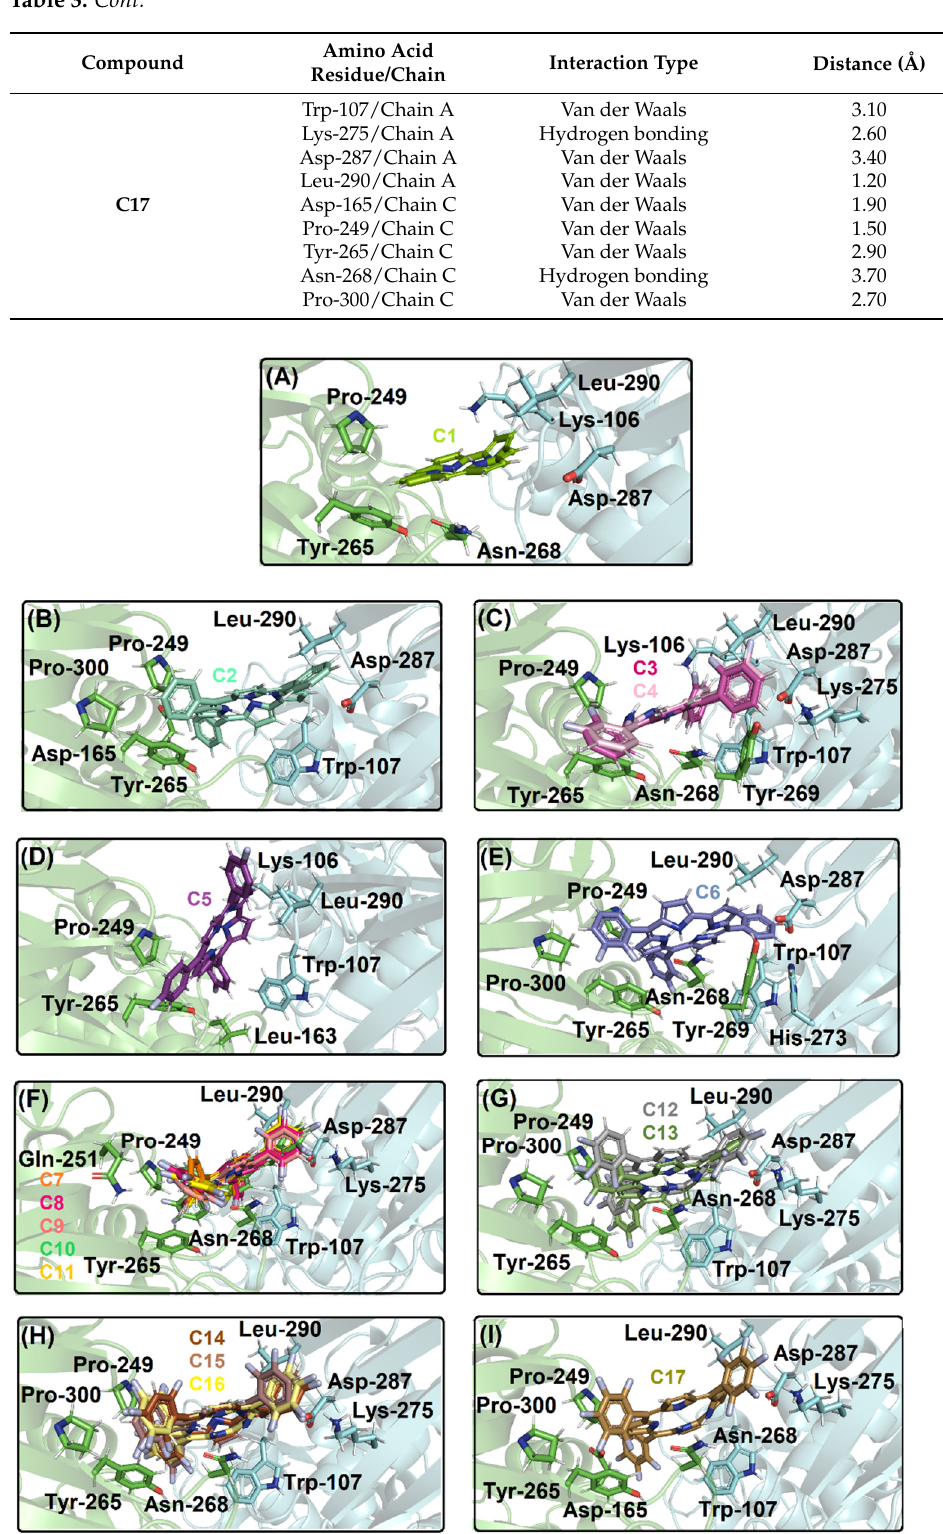
Figure 5. The best docking pose into the catalytic site of PL pro for ( A ) C1 ; ( B ) C2 ; ( C ) C3 , C4 ; ( D ) C5 ; ( E ) C6 ; ( F ) C7 , C8 , C9 , C10 , C11 ; ( G ) C12 , C13 ; ( H ) C14 , C15 , C16 ; and ( I ) C17 . The PL pro structure is in cartoon representation divided into chains A, B, and C in blue, light gray, and green, respectively. The selected amino acid residues into chain A and C are in stick representation in blue and green, respectively. The chemical structure and the corresponding carbon’s color of each corrole that was used in this study is in stick representation according to the 3D chemical structure of the Figure 1. The elements’ color: hydrogen, nitrogen, fluorine, and oxygen in white, dark blue, light blue, and red, respectively.